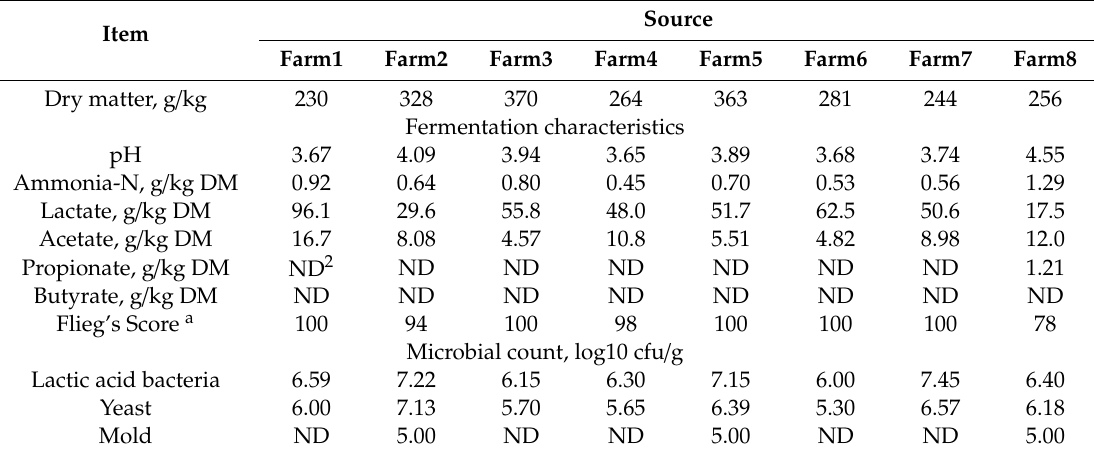
Table 1. Dry matter content, fermentation characteristics, and microbial counts of corn silages collected from beef cattle farms as isolate sources (n =